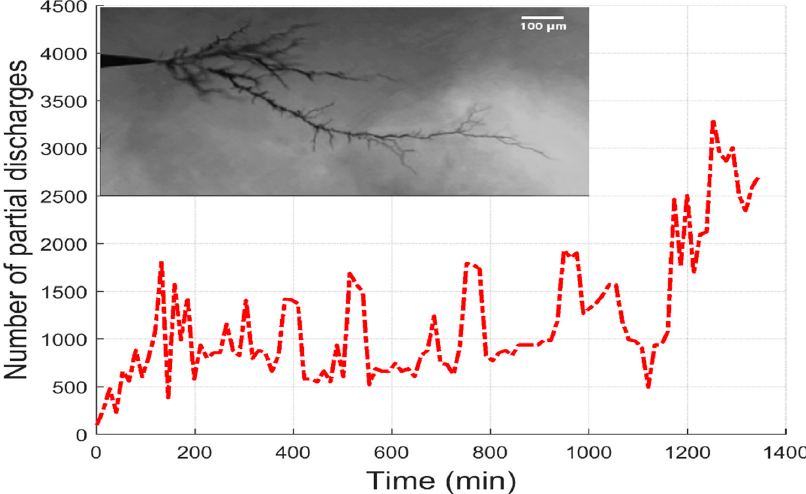
Figure 13. Partial discharge activities of ET growth under polarity reversal for case (II) in Table 4.